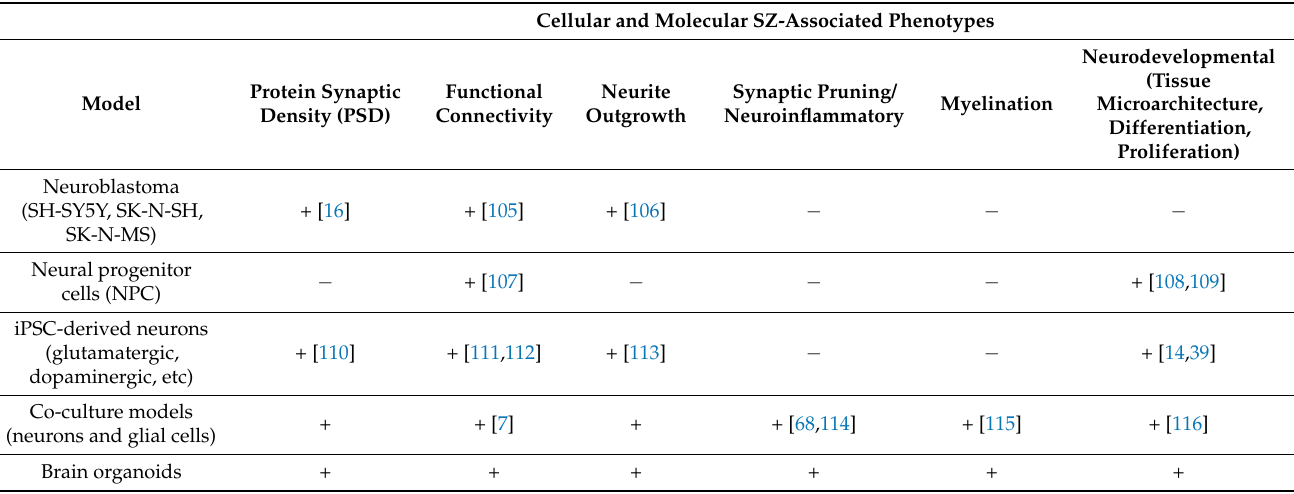
Table 1. In vitro models used to study cellular and molecular SZ-associated phenotypes.